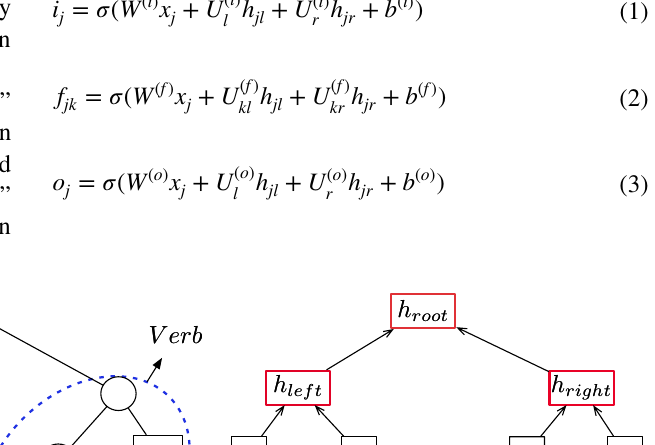
What doesproducts